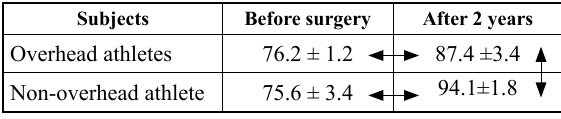
Table 2. Constant score values before surgery and after two years